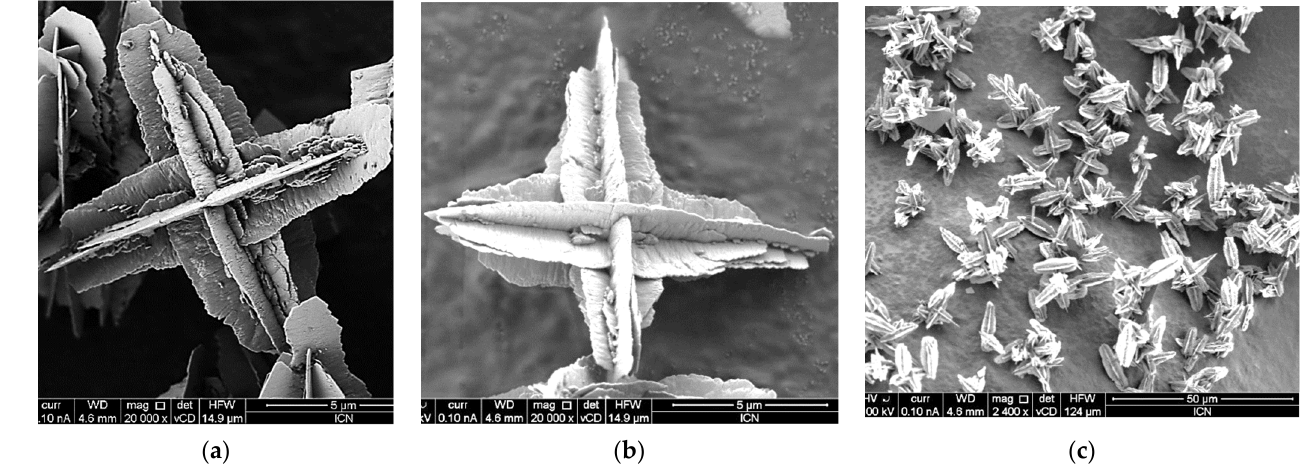
Figure 7. SEM micrographs of vanadium oxide VO 2 micro- crosses (VOx-MC): ( a – b ) detailed cross morphology exhibiting four split VO 2 folds; ( c ) clustered micro-crosses and long scan exhibiting the yield and morphological aspect.